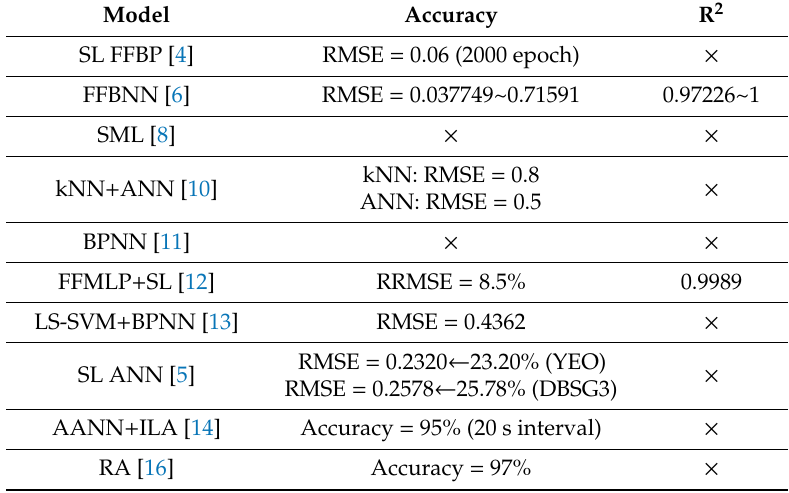
Figure 8. These radar maps show the supported maximum frequency limit, types of supported links (earth-space or terrestrial or both), support for polarization characterizes, and the number of input parameters associated with LARA models. This radar map is visualized with the data from Tables 2 and 3. For better visualization, data range was rescaled from − 5 to + 15. Table 5. Accuracy and R 2 of the LARA